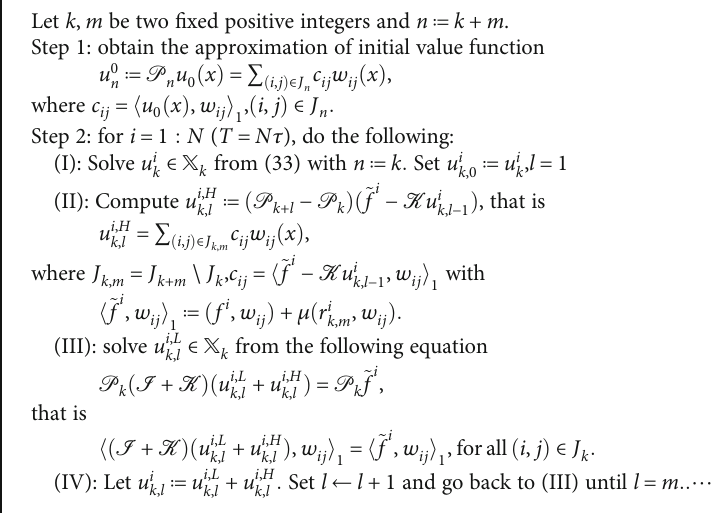
Algorithm 1: (MAM for time fractional Burgers